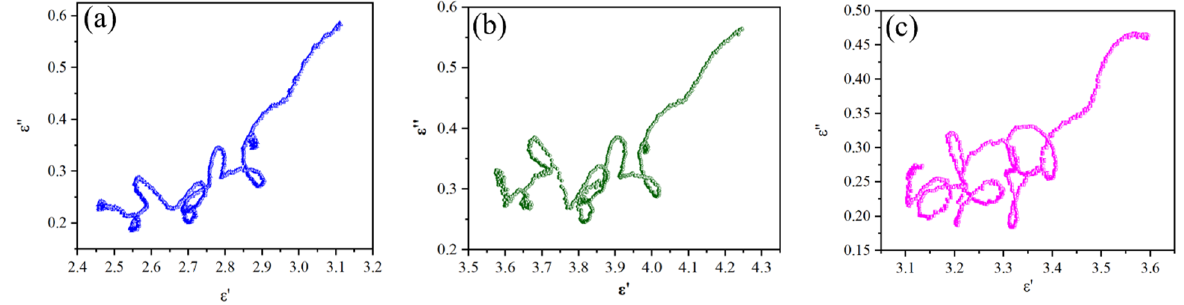
Figure 9. Cole–Cole plots of ( a ) HEO − Zn, ( b ) HEO − Cu, and ( c ) HEO − Mn.